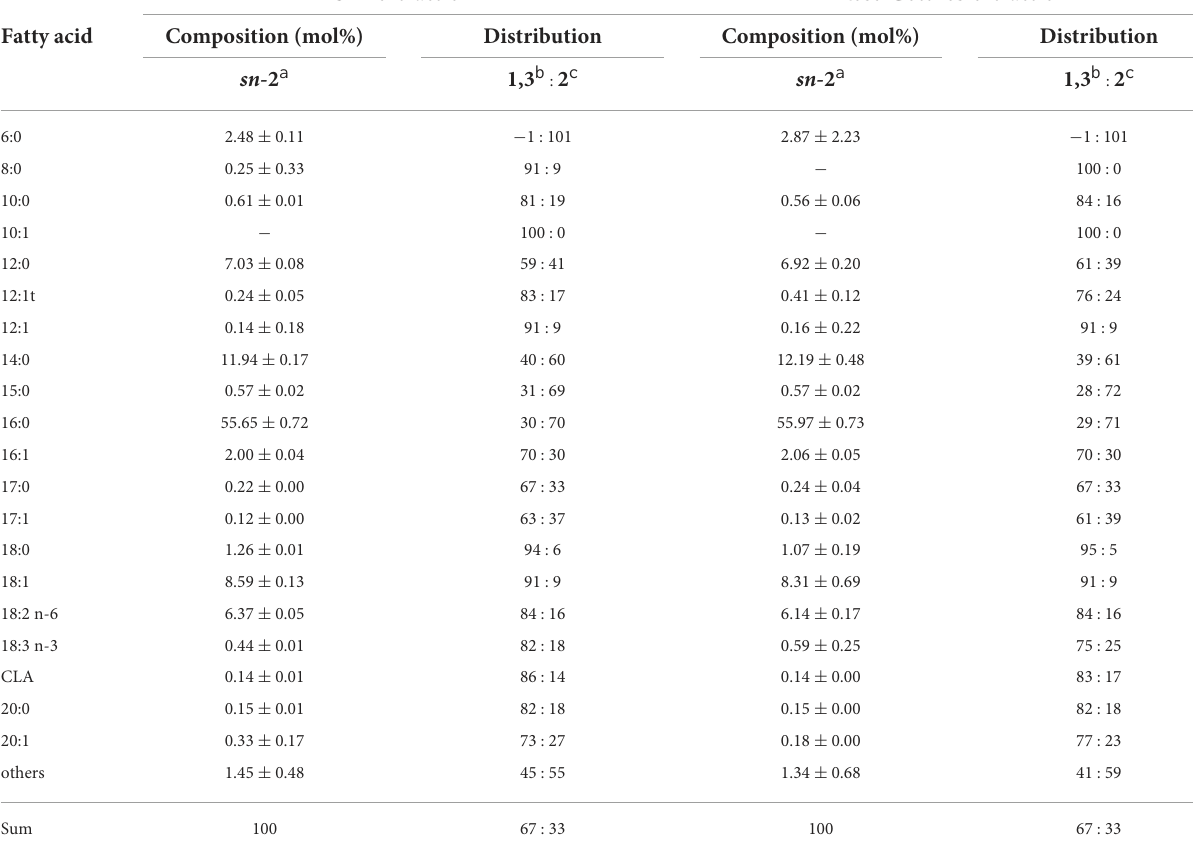
TABLE 4 FA composition at sn -2 and FA distribution in high fat milk analyzed by Joint JOCS/AOCS Official Method Ch 3a-19. SPE